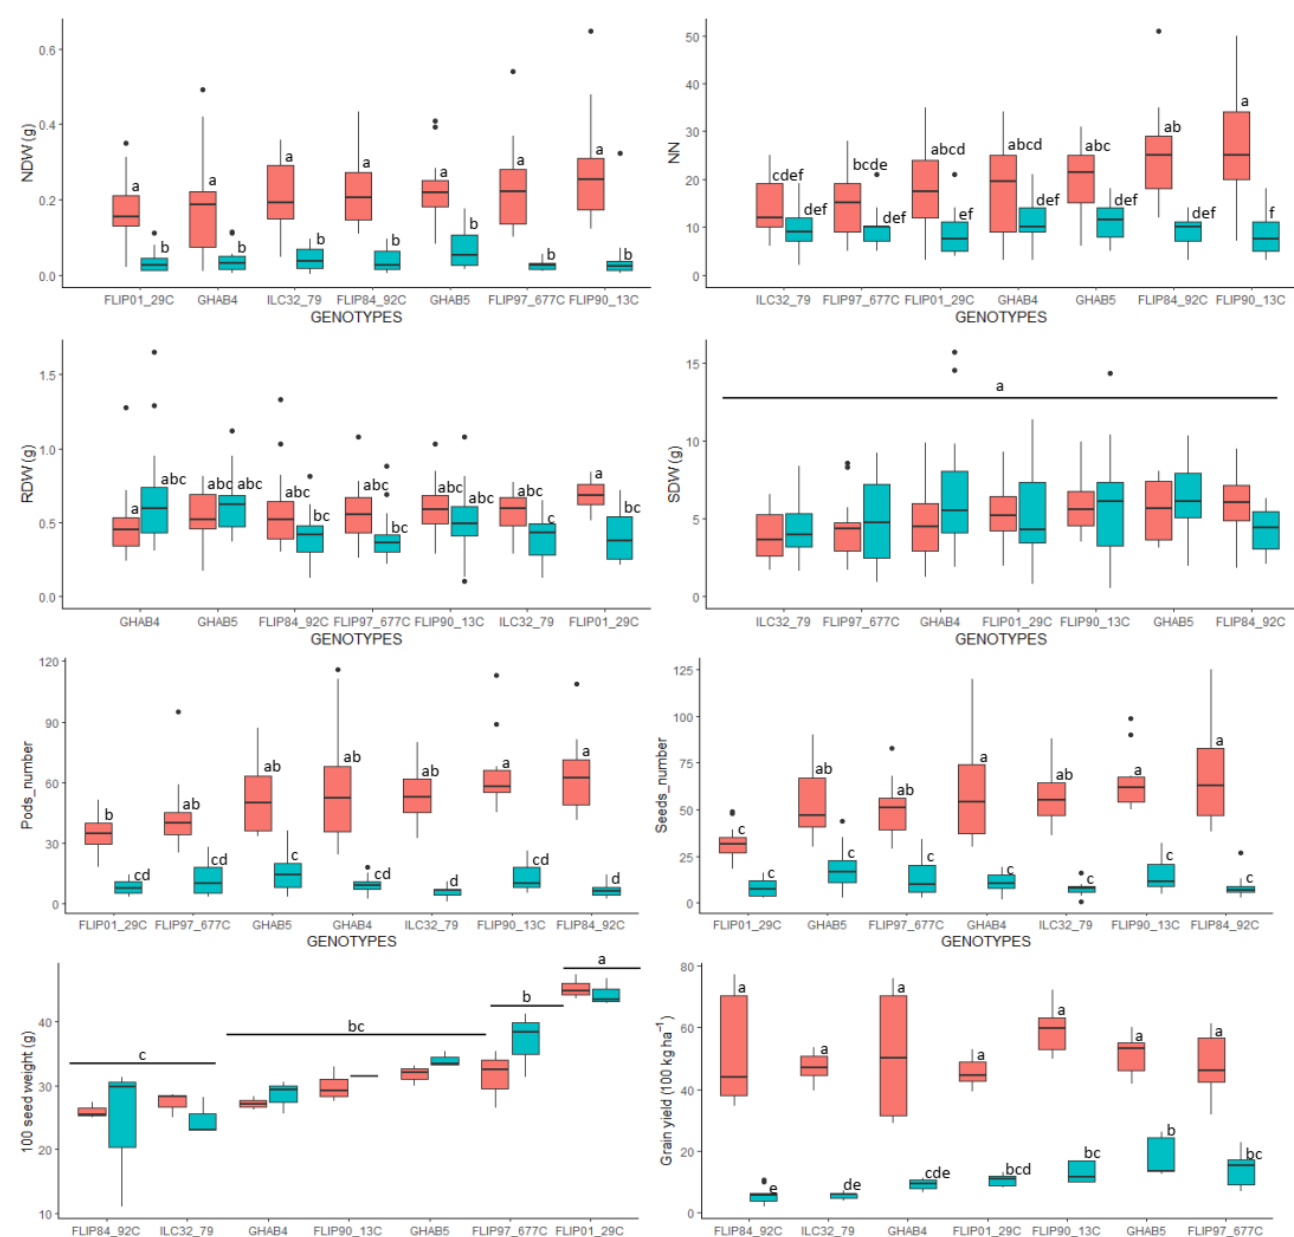
Figure 2. Evaluation of the plant growth, nodulation performances and yield components of the seven chickpea cultivars grown under low-P availability field conditions during two cropping seasons. Nodule biomass ( a ), nodule number ( b ), and roots and shoot biomass ( c , d ) were measured at the flowering stage while pod numbers ( e ), seed numbers ( f ), 100 seed weights ( g ), and grain yield ( h ) were recorded at grain maturity, from eighteen replicates for each of the two growing seasons in 2018 (red) and 2019 (blue). The distribution of these continuous variables is plotted using boxplots that display the median, first and third quartiles, and outliers. Letters identify significantly different groups, according to the Tukey test for multiple mean comparisons at p = 0.05. NDW, nodule dry weight; NN, nodule number; RDW, root dry weight; SDW, shoot dry weight.